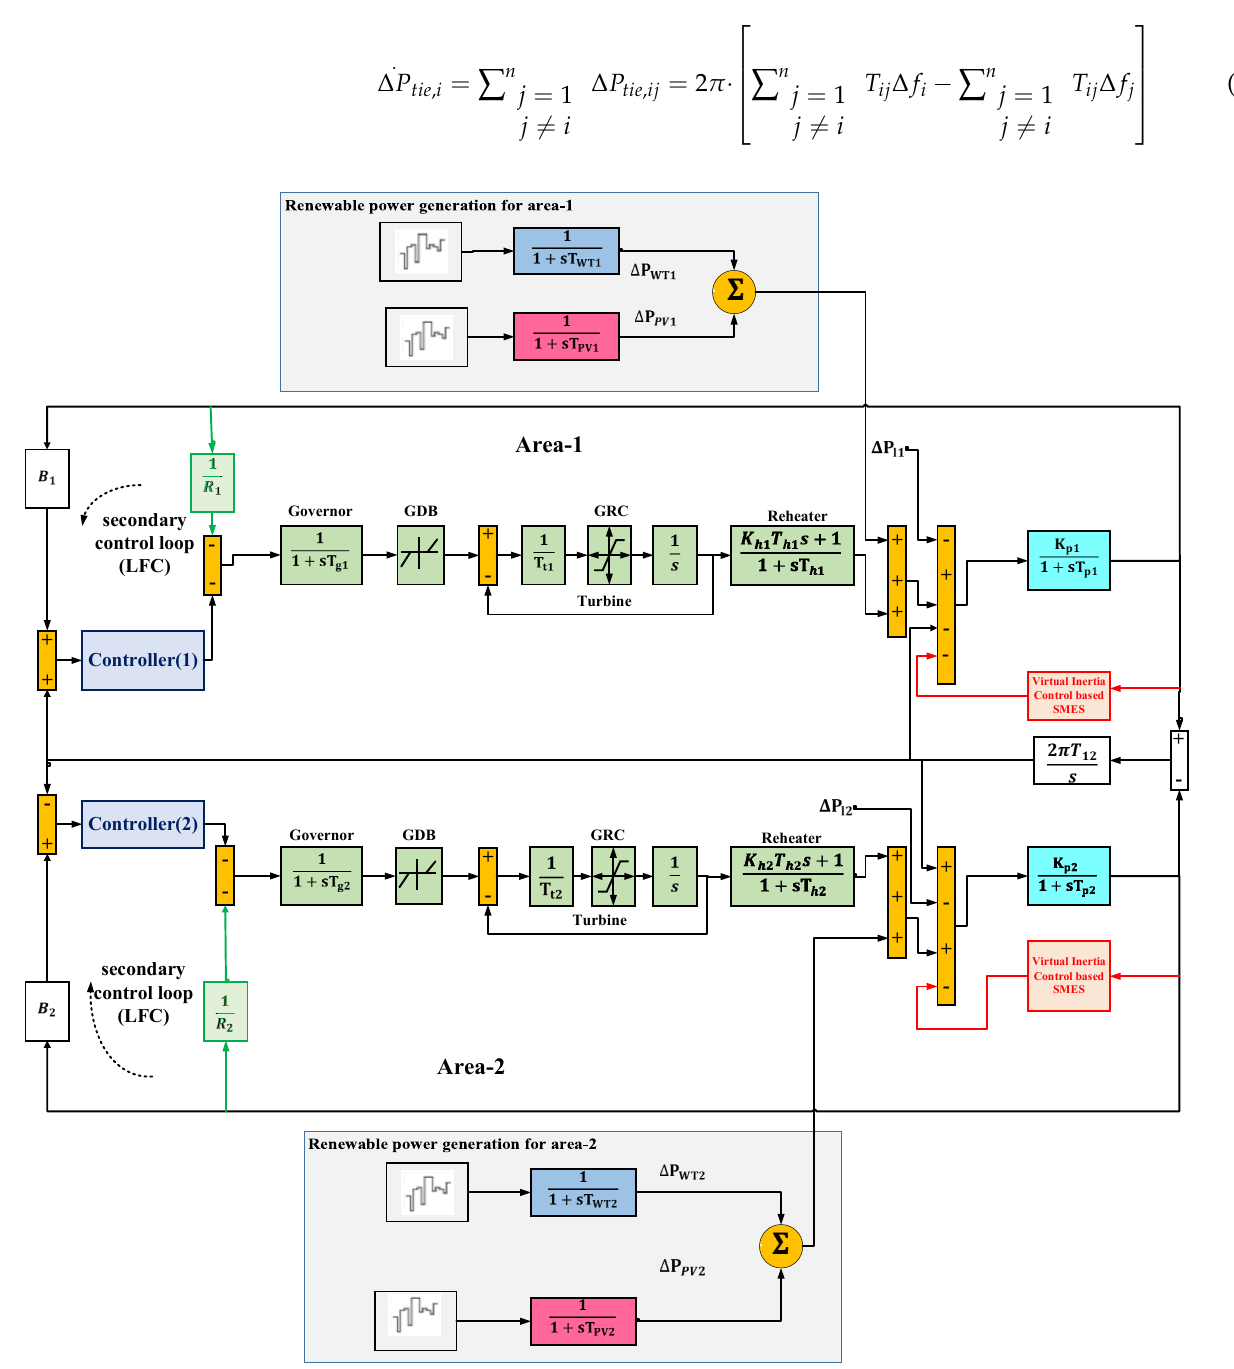
Figure 2. The simplified block diagram of the system under consideration.